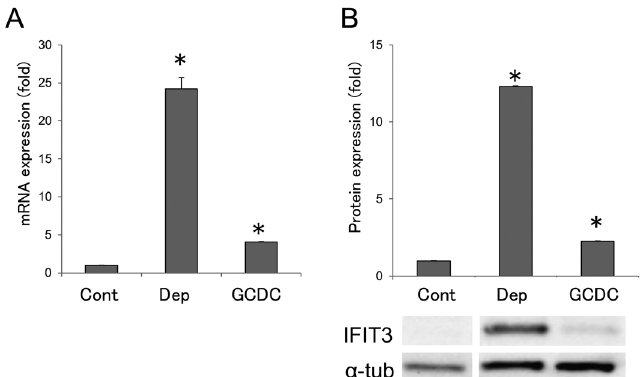
Figure 1. IFIT3 expression was increased in senescent cells in mRNA and protein level. ( A ) The expression of Ifit3 mRNA was significantly increased in senescent BECs induced by serum depletion and GCDC. * p < 0.01 compared to control. ( B ) The expression of IFIT3 protein was significantly increased in senescent BECs induced by serum depletion and GCDC. * p < 0.01 compared to control. Blots were cropped from different parts of the same gel/blot (Supplementary information